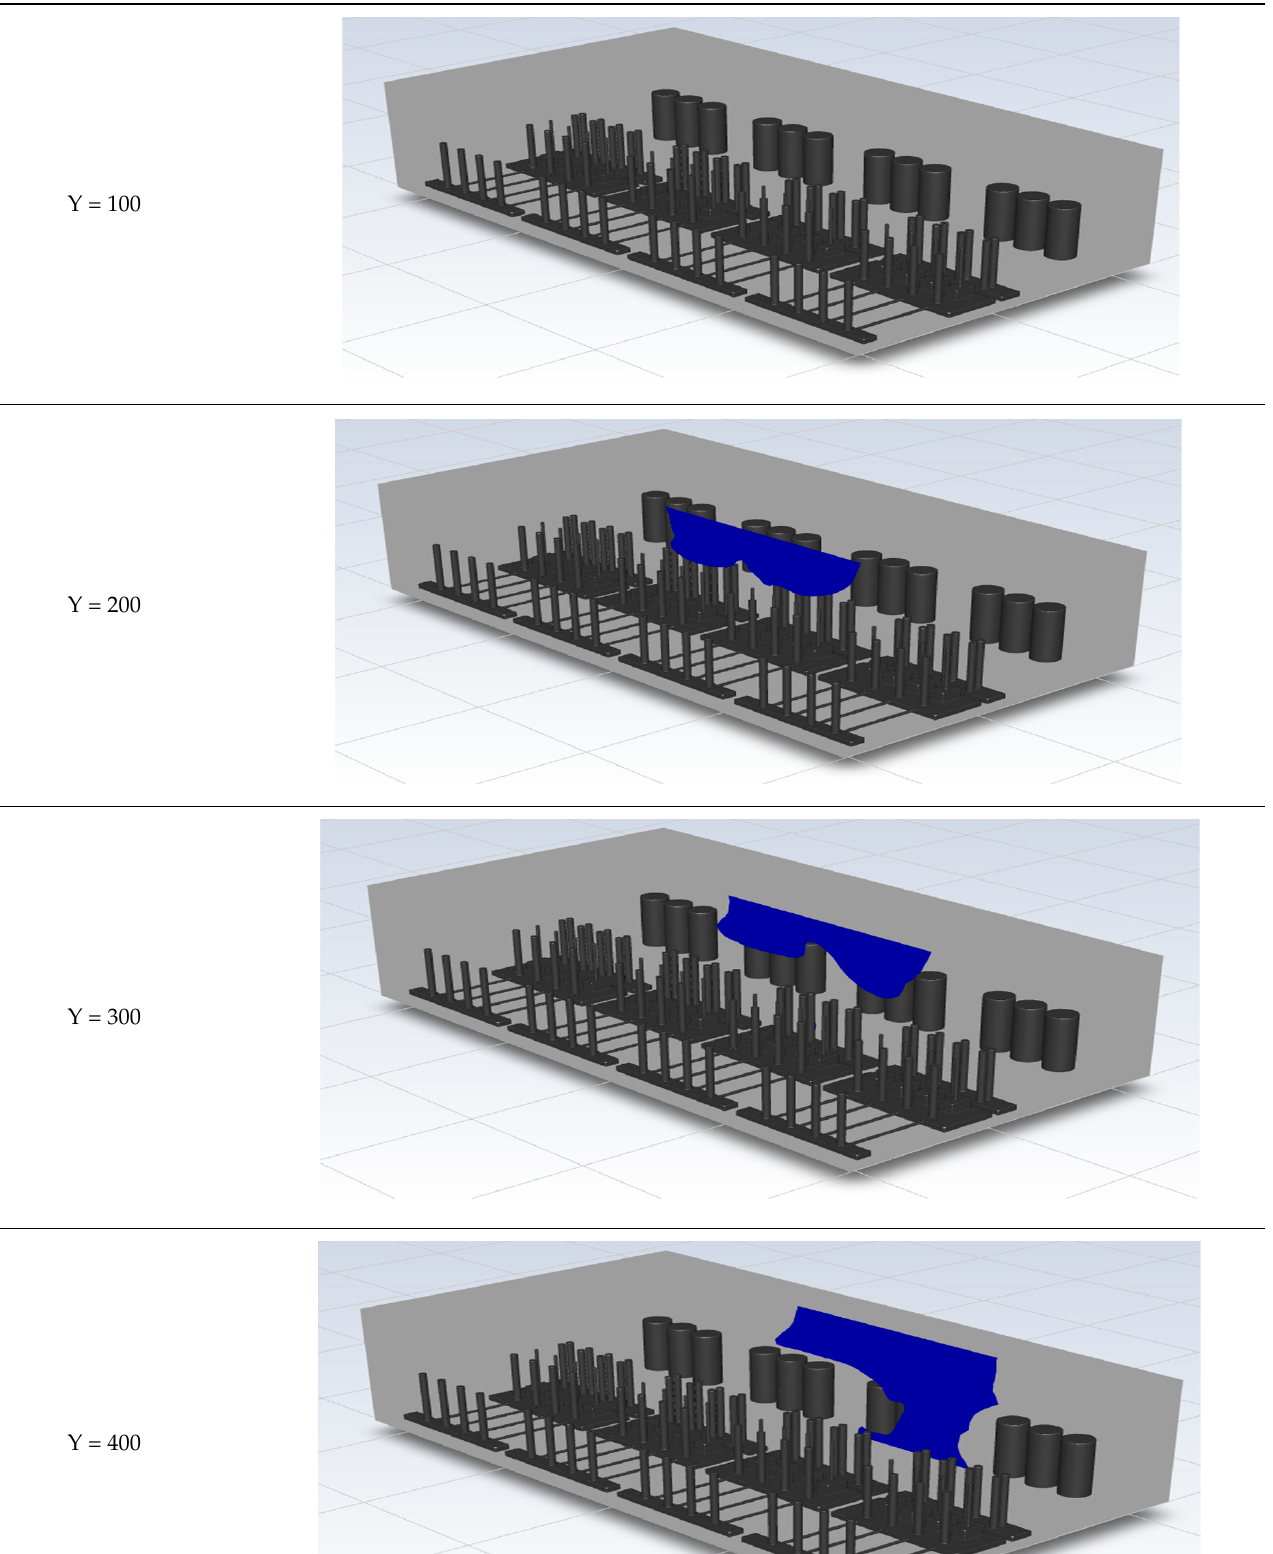
Table 10. Distribution of concentrations exceeding 25% of the LFL on the XY section.